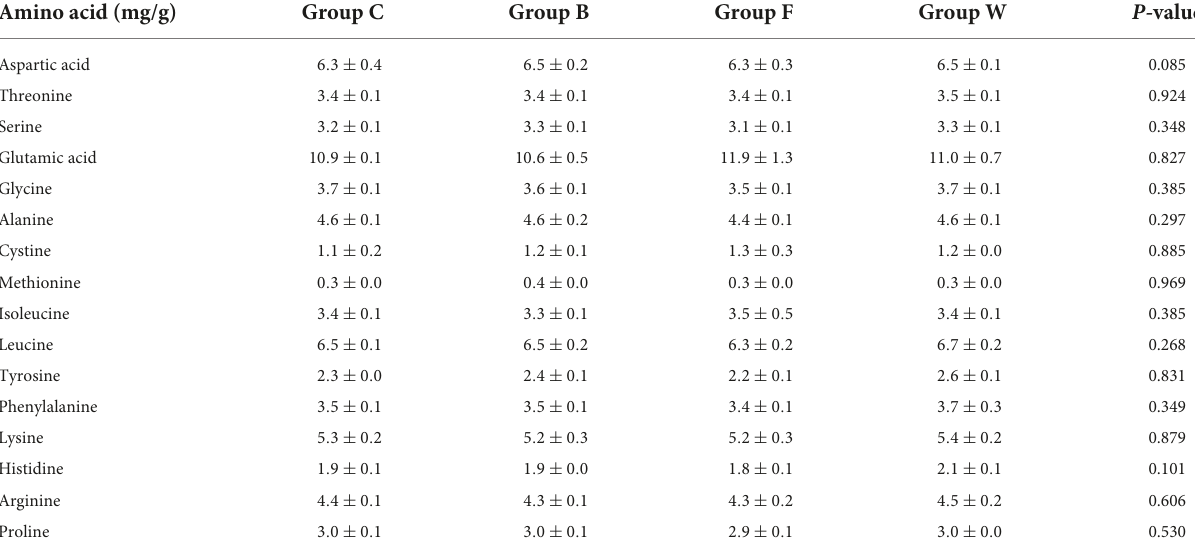
TABLE 5 Effect of brewers’ spent grain (BSG) on the compositions of amino acids in the livers of four groups of Landes geese (i.e., groups C, B, F, and W) in 90 days. Amino acid (mg/g) Group C P -value Aspartic